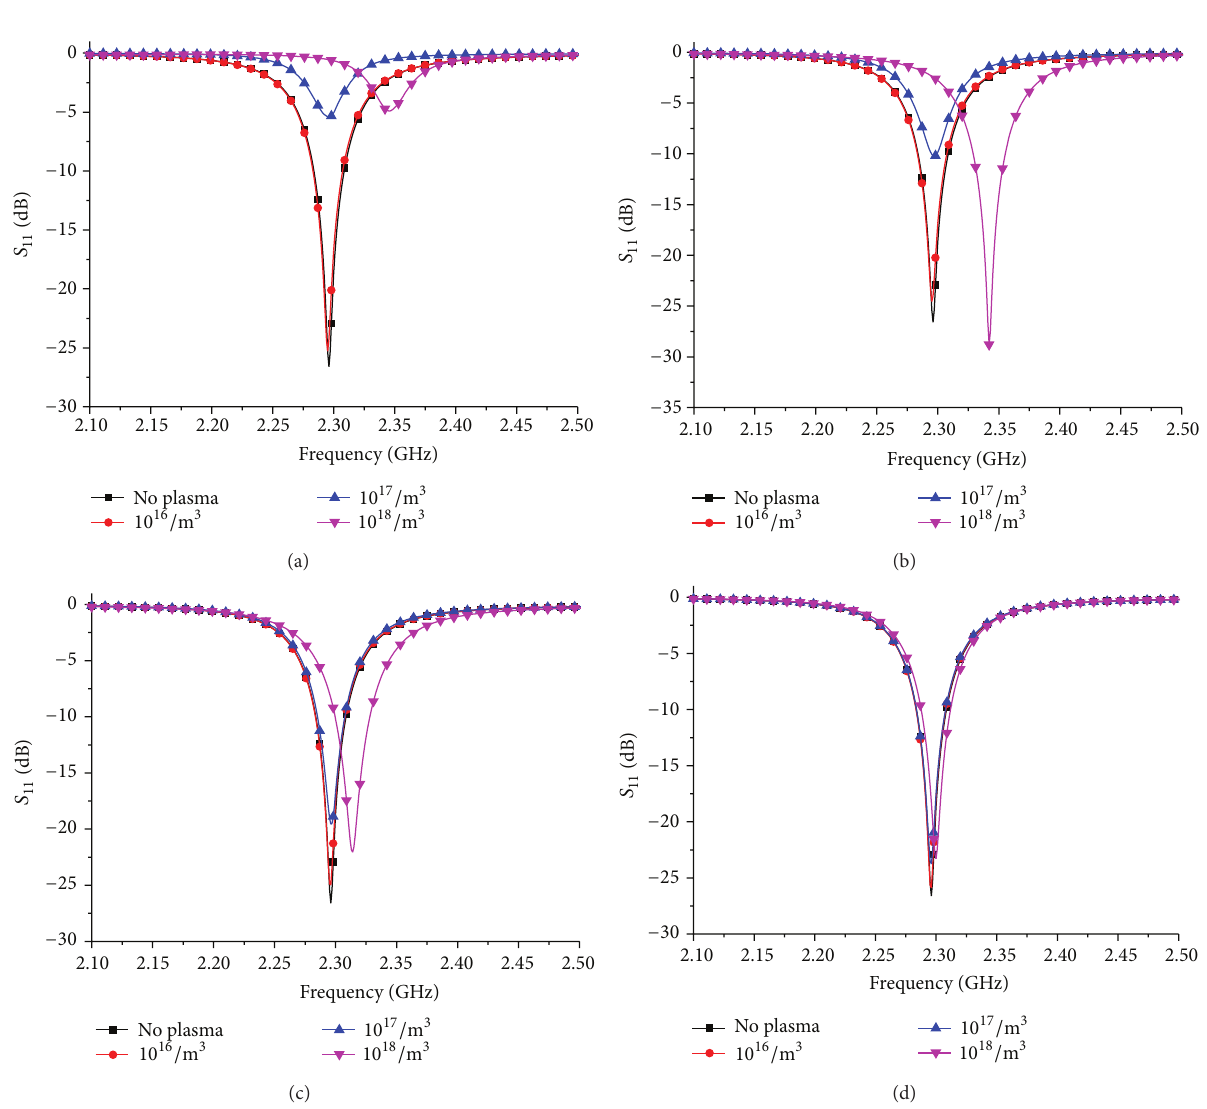
Figure 5: (a) Self-coupling coefficient ( ] = 0.1 GHz) of array element. (b) Self-coupling coefficient ( ] = 1 GHz) of array element. (c) Self- coupling coefficient ( ] = 5 GHz) of array element. (d) Self-coupling coefficient ( ] = 20 GHz) of array